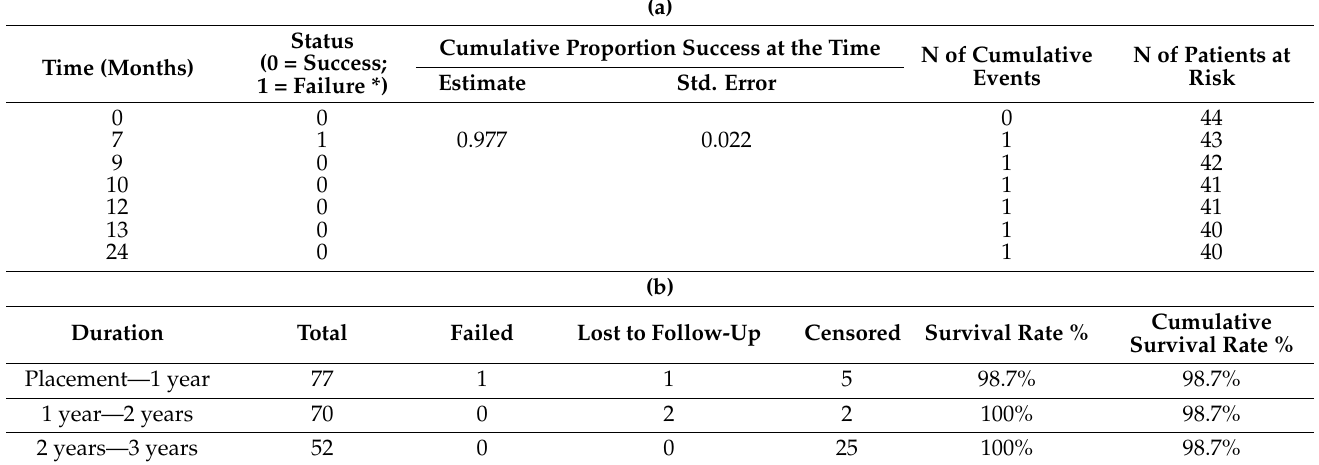
Table 2. (a) Study implants and study abutments survival in complete edentulous rehabilitations using the patient as unit of analysis (Kaplan-Meyer product limit estimator). (b) Life table for cumulative survival rate of the study zygomatic implants and study abutments of 45 and 60 degrees using the implants/abutments as unit of analysis.